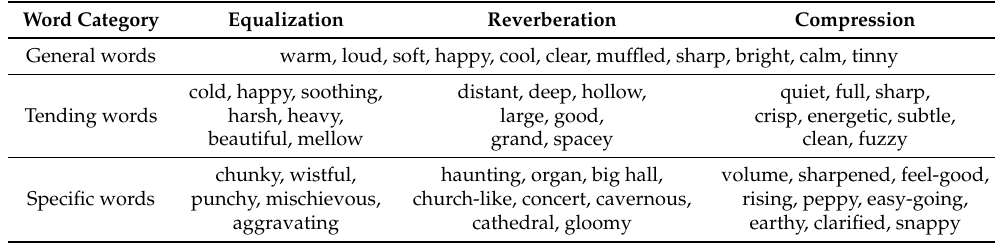
Table 1. Descriptors and which audio effect they are related to. General words are used to describe audio effects produced by any of the three effects tools. Tending words are ones which were shown predominantly for a single audio effect, but appear in other audio effect vocabularies with low frequency. Specific words are ones that are used for a single audio effect and no others. The words shown above were found via inspection of the shared descriptor space between the three audio